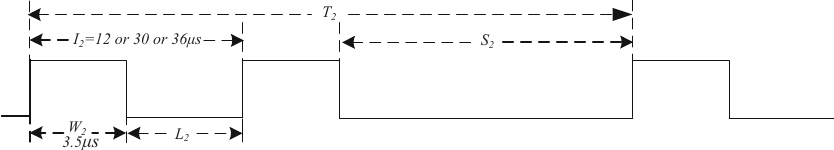
Figure 1. The basic pulse pair of Distance Measuring Equipment (DME) signal.